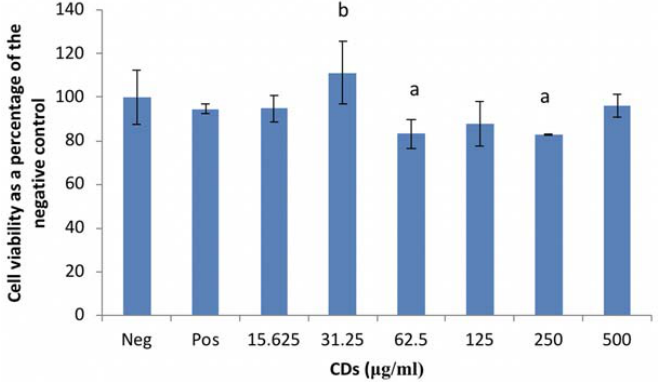
Figure 1. Cell viability of RAW 264.7 macrophage cells exposed to carbon dots (CDs). Data represents mean ± SD. with n = 9. Bars marked with letters indicate significant differences ( p < 0.01). Significance.